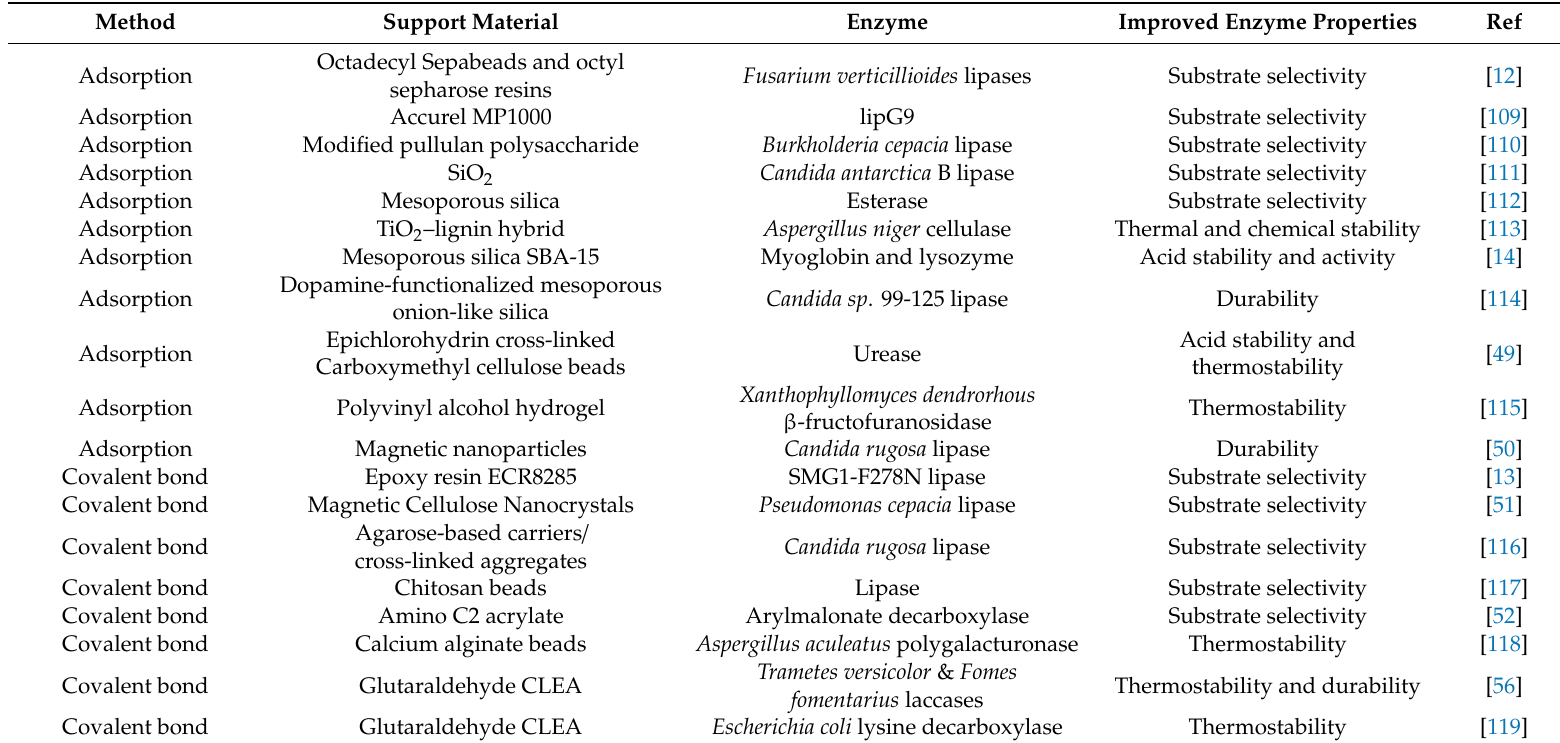
Table 1. Typical research on improving enzyme properties by immobilization